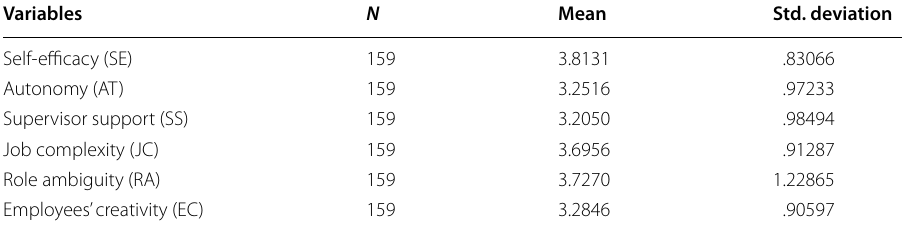
Table 4 Descriptive statistics. Source: own survey (2020) Variables